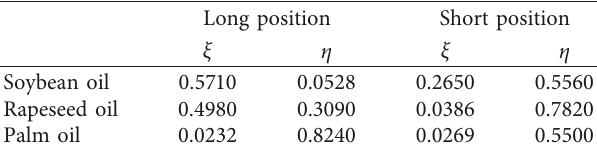
Table 6: GPD fitting